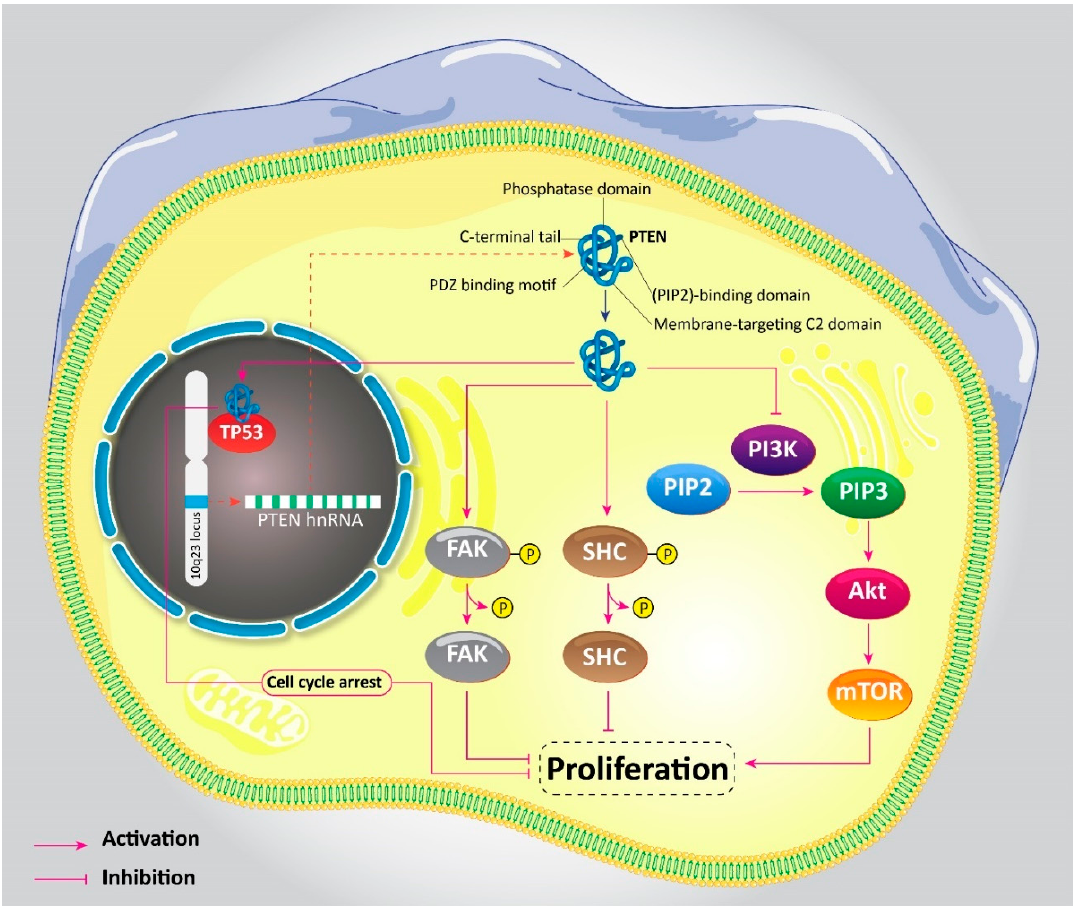
Figure 1. Phosphatase and tensin homolog (PTEN) signaling pathway and its interactions.